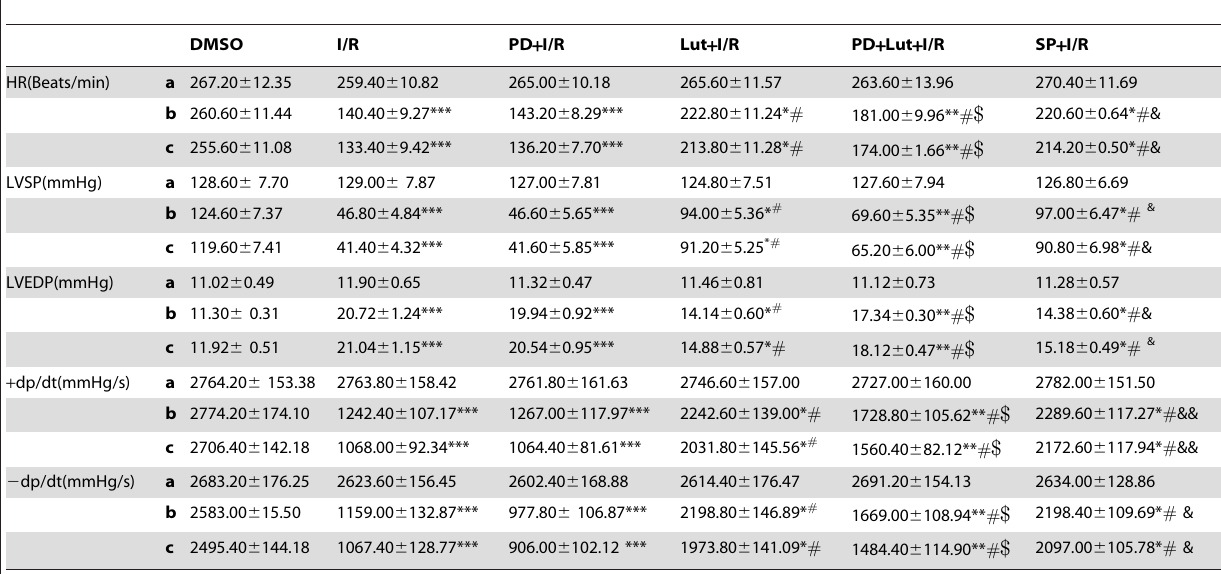
Table 1. Each group of Myocardial Function in Isolated Ischemia/Reperfused